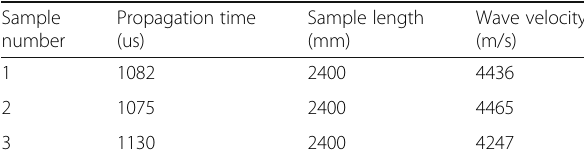
Table 2 Test results of three